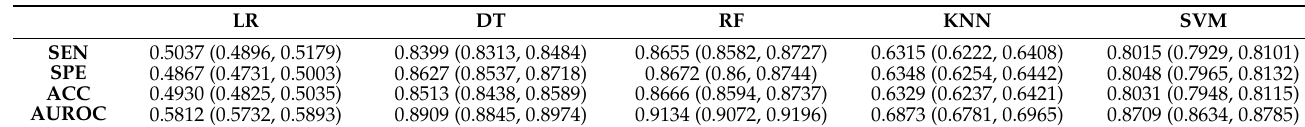
Table 1. Diagnostic performance of the models. The metrics are expressed by means and 95%